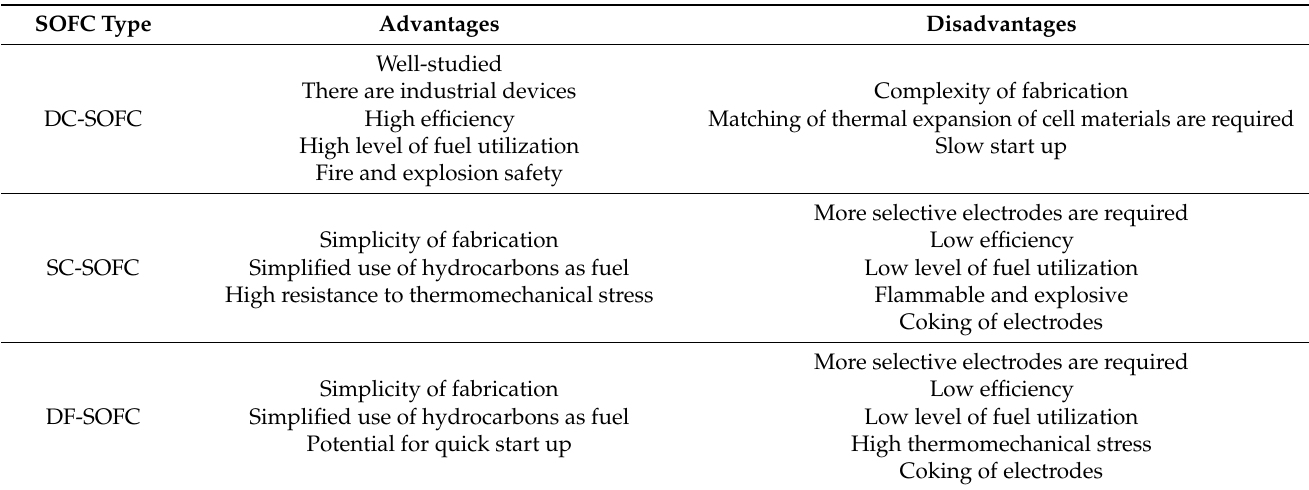
Table 2. Features of DC-SOFC, SC-SOFC, and